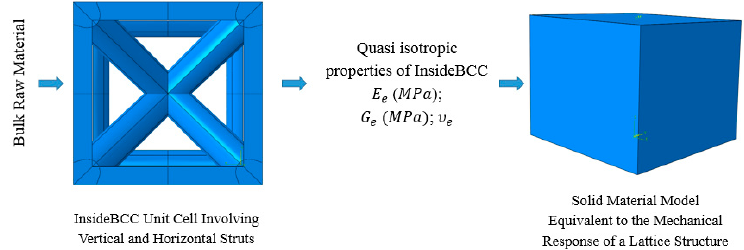
Figure 2. A methodology strategy from unit cell finite elemental analysis (FEA) model to equivalent solid model of InsideBCC configuration.